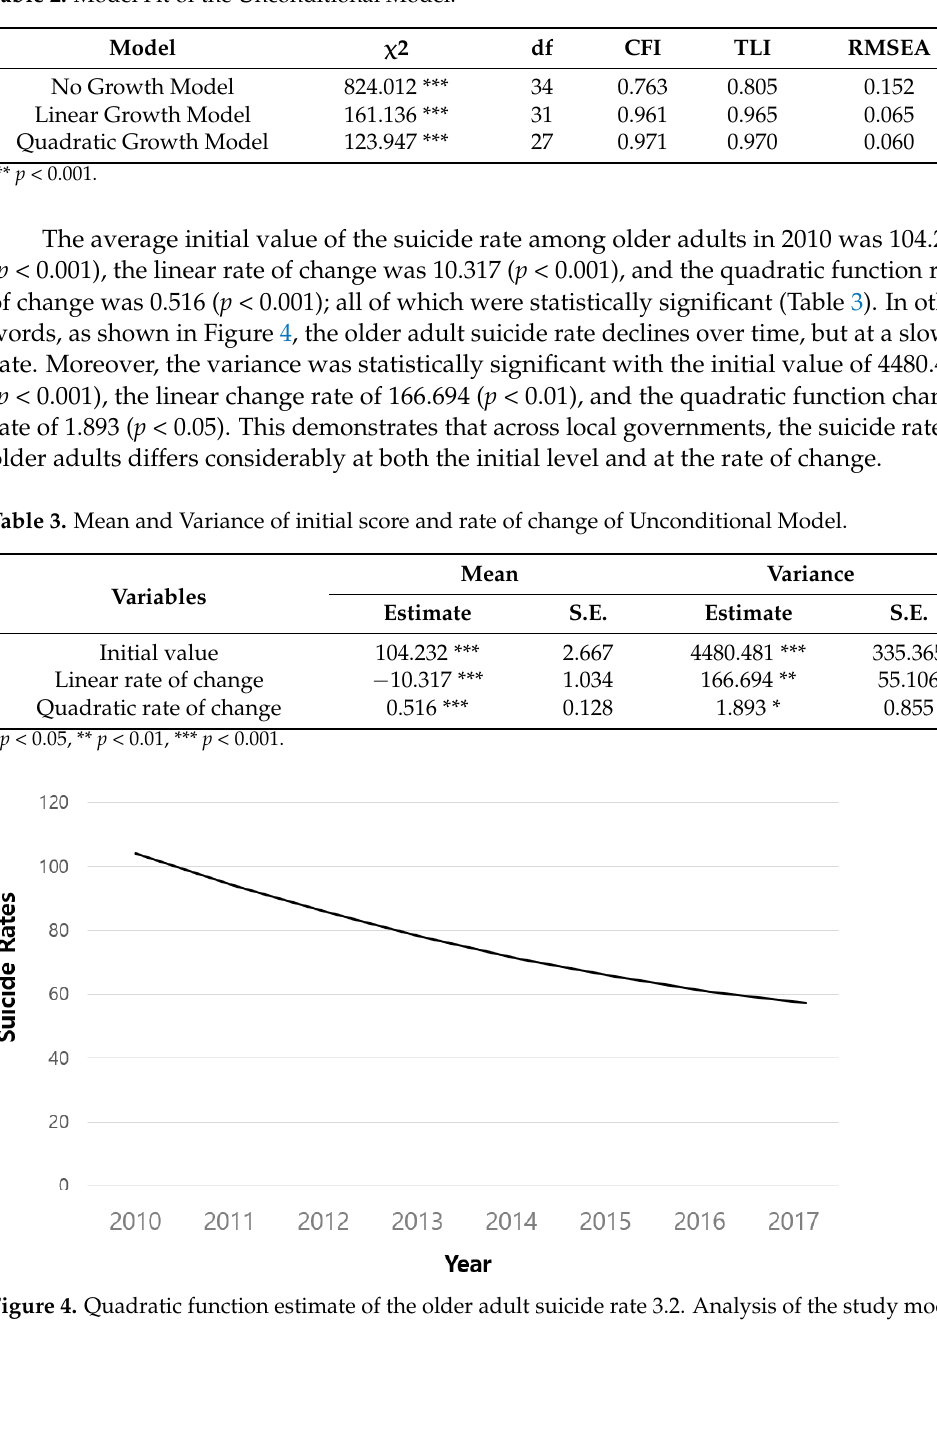
Table 2. Model Fit of the Unconditional Model.